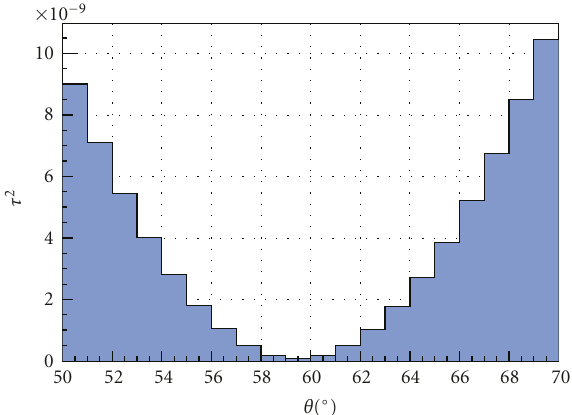
Figure 10: Cut through the θ − ϕ plane at ϕ min of the minimum computed with the time di ff erence method.